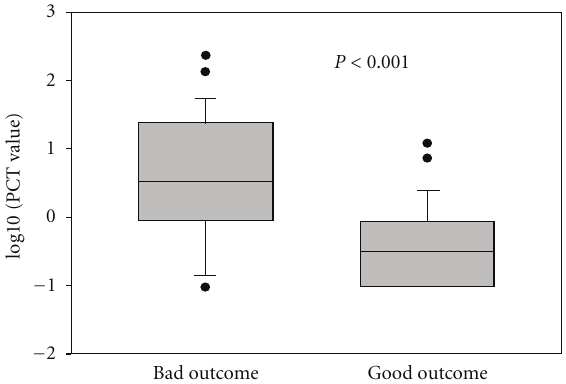
Figure 1: PCT values according to outcome. Patients with bad outcome have significantly higher PCT levels than patients with good outcome. Log10-transformed data are shown.